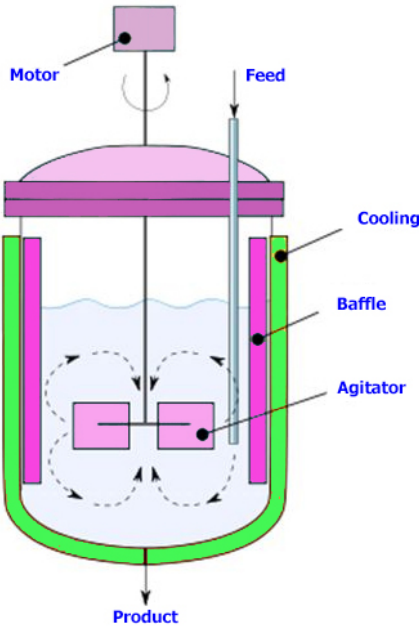
Figure 4. CSTR Unit performance process.